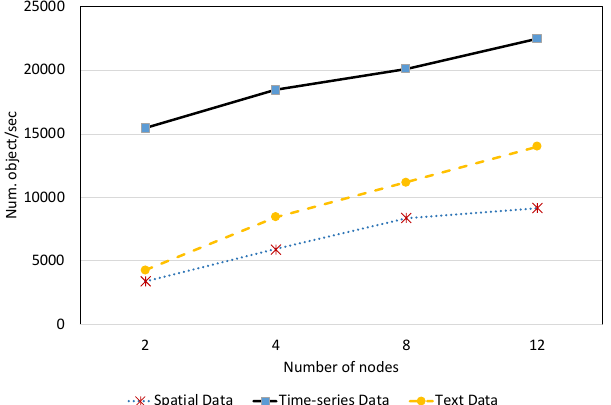
Figure 25. Average index throughput by varying number of cluster nodes.